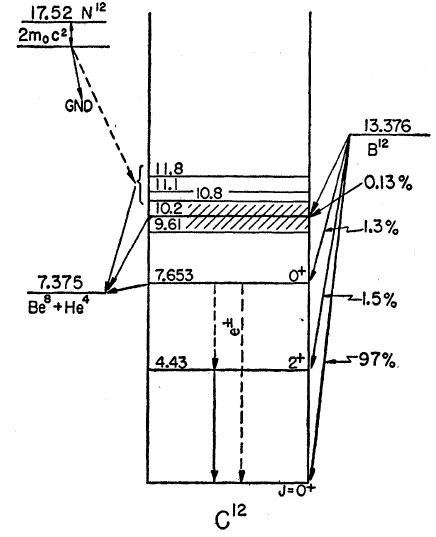
Figure 12: The final experiment by Cook et al. 1957: Figure 8.17: Cook et al. 1957 created the ra- dioactive nucleus 12 B which decays into 12 C . Most creates the nucleus 12 B and follow its decay into the of the decays go into the ground state and only 7.653MeV level (only 1 . 3%). 1 . 3% go into the investigated level.